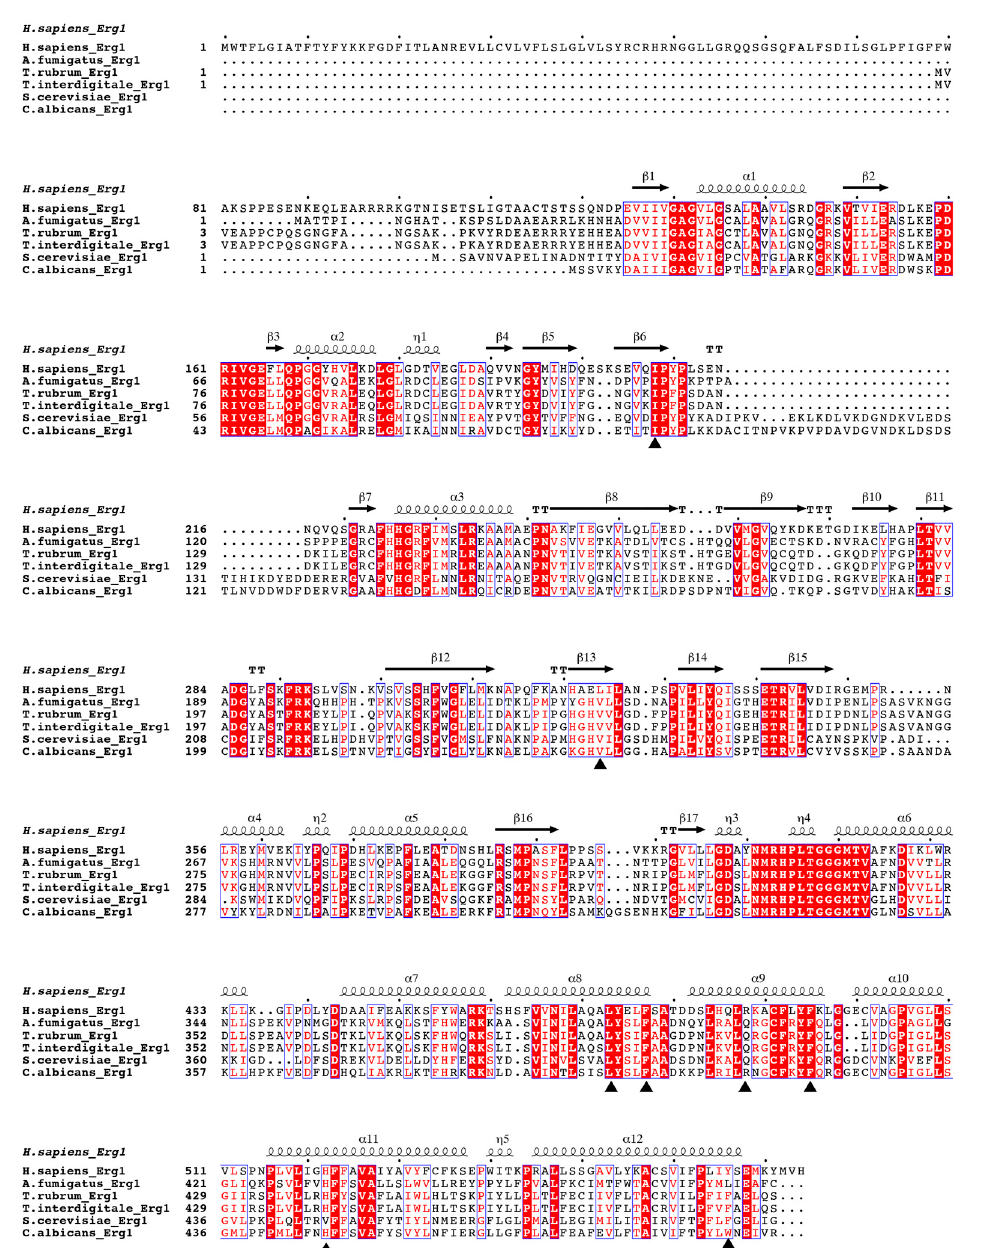
Figure 4. Sequence alignment of the human SM and fungal Erg1s. Sequence alignment was done using Clustal Omega [61] and the figure was generated using the ESPript 3.0 [62] online server using PDB ID 6C6P for secondary structure designation. The sequences were obtained in Uniprot H. sapiens (accession number Q145334), S. cerevisiae strain S288c (accession number P32476), A. fumigatus Z5 (accession number A0A0J5PRX5), T. interdigitale strain MR 816 (accession number A0A059JE48), T. rubrum (accession number Q4JEY0), C. albicans strain SC5314 (accession number Q92206). Conserved residues are highlighted in red and similar residues are shown in the red font. Mutations which confer reduced terbinafine susceptibility in dermatophytes T. rubrum and T. interdigitale are designated with triangles. The secondary structure is annotated as α for α -helices (curved line), β for β -strands (arrow), and η for 3 10 -helices, the dots on the top of the sequences appear every ten residues.